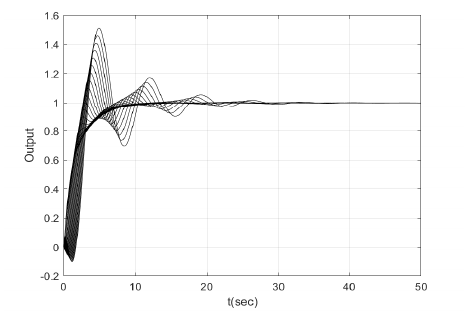
Figure 7. Unit step responses of the first order approximation and the second order Pad´e for h = 0 . 1 : 0 . 1 : 1 . 2, and k p =k i